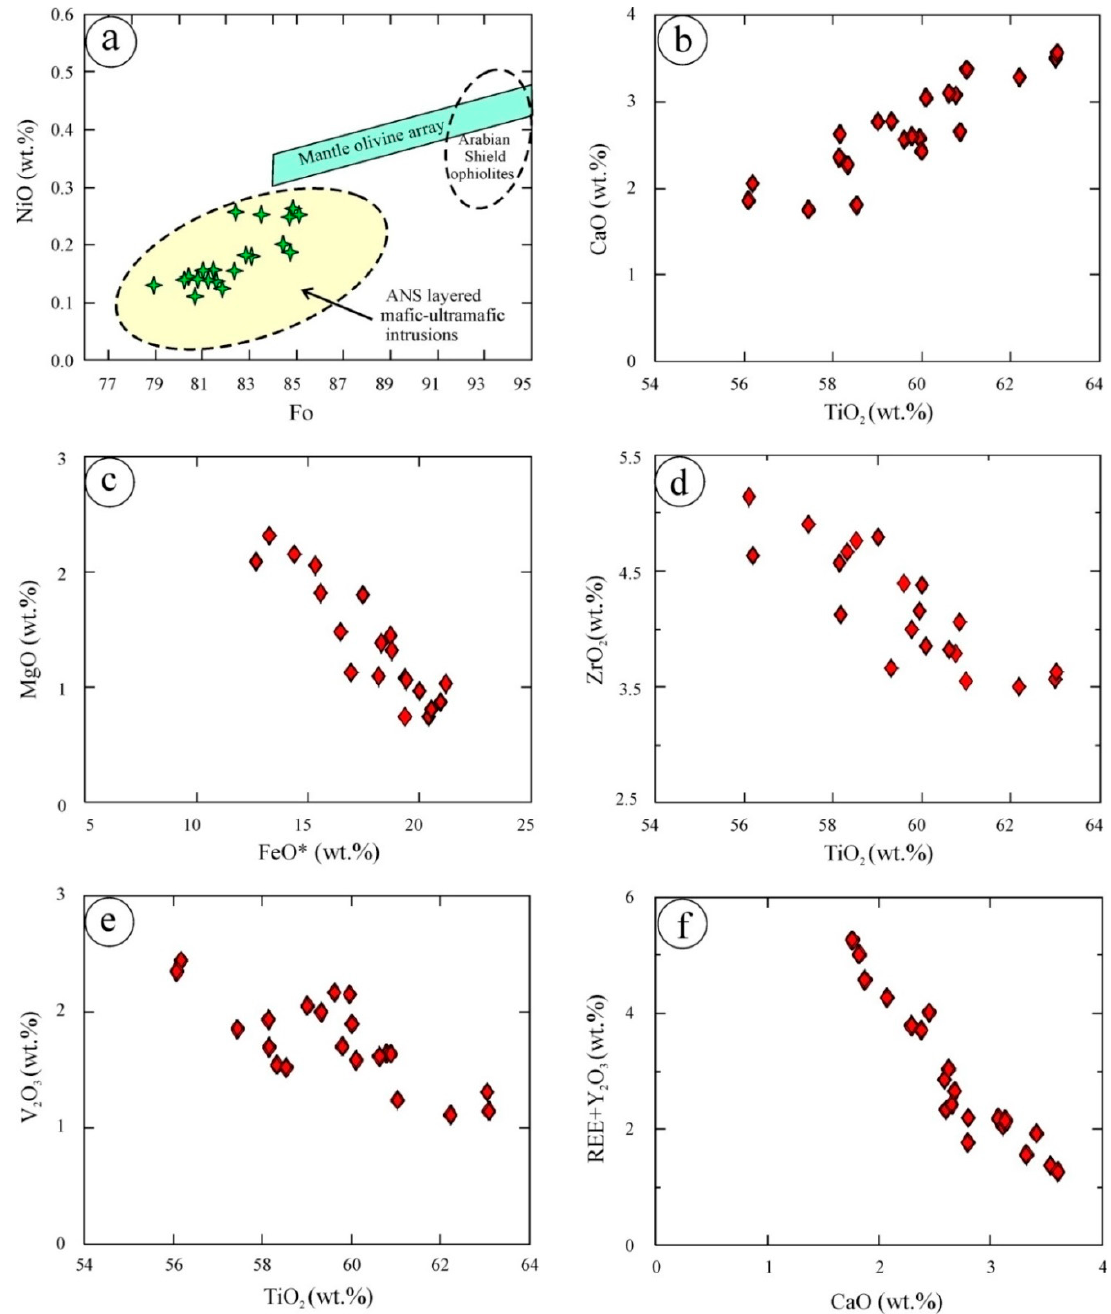
Figure 4. Mineral chemistry of the olivine gabbro: ( a ) variation of NiO (wt.%) and Fo contents of olivine in the olivine gabbro compared to the mantle olivine array [27], ANS layered intrusions [19,21,22]; and Arabian Shield ophiolites [13,23–26], ( b – f ) loveringite composition: ( b ) TiO 2 vs. CaO, ( c ) FeO* vs. MgO, ( d ) TiO 2 vs. ZrO 2 , ( e ) TiO 2 vs. V 2 O 3 , and ( f ) CaO vs. REE + Y 2 O 3 .